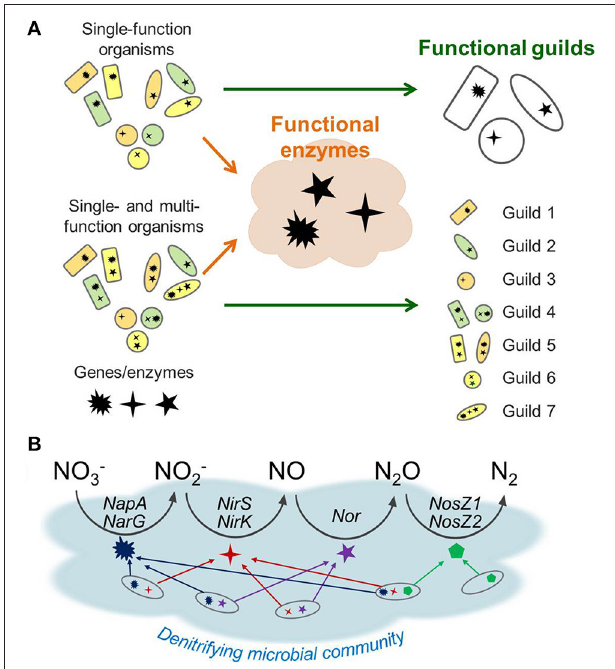
FIGURE 1 | A schematic representation of trait-based microbial community modeling strategies: (A) functional guild- vs. functional enzyme-based formulations, (B) enzyme-based modeling of denitrification. In (A) , communities are considered as being composed of specialists (that can express one functional enzyme) only, or being mixed with specialists and functionally versatile organisms (that can express multiple enzymes). In (B) , the latter case is illustrated using denitrification, which is composed of four steps of reduction catalyzed by distinct sets of genes and enzymes: NapA and NarG for NO − 3 reduction to NO − 2 , NirS and NirK for NO − 2 to NO, Nor for NO to N 2 O, and NosZ1 and NosZ2 for N 2 O to N 2